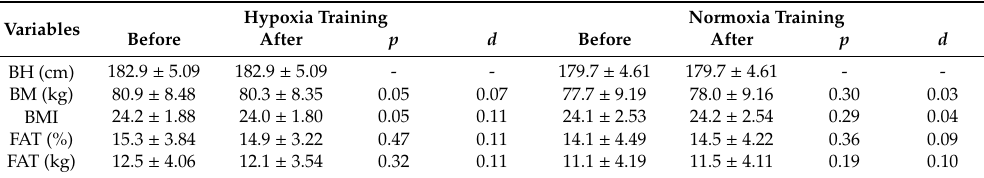
Table 3. Participants’ physical